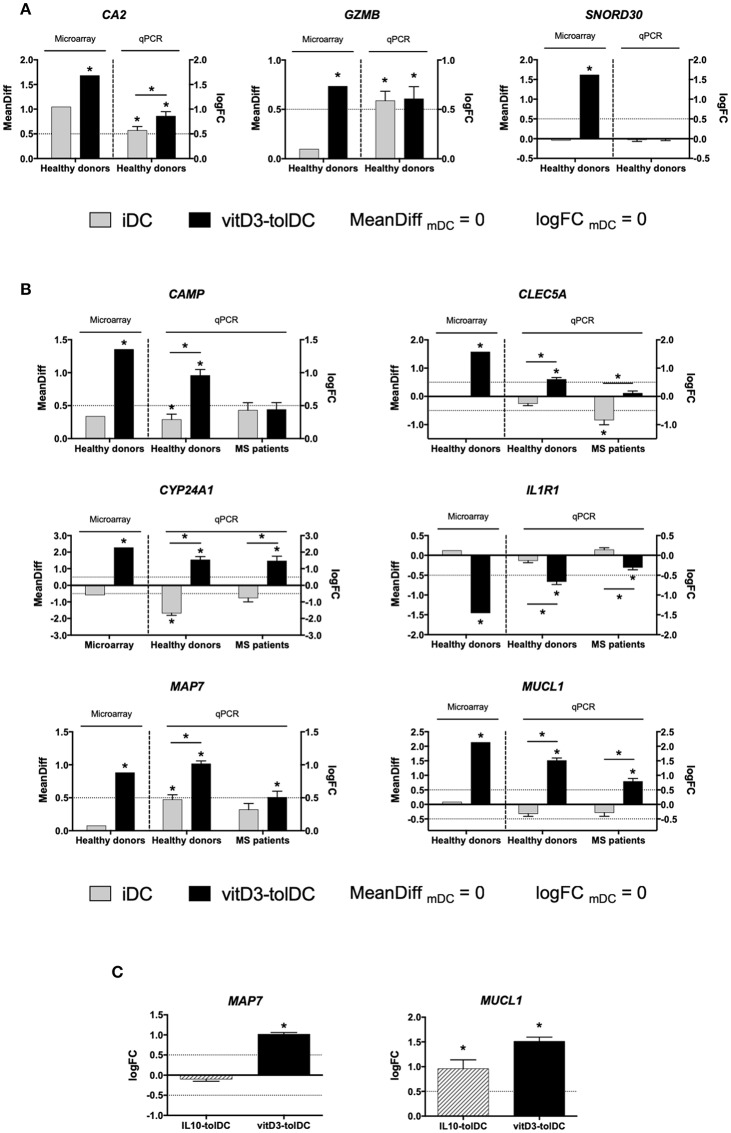
Expression of the selected genes as candidate biomarkers of vitD3-tolDC. (A) Expression of CA2, GZMB and SNORD30 in healthy donors by microarray (n = 5) and quantitative PCR (qPCR; n = 20, except CA2, in which n = 24) in immature dendritic cells (iDC), mature DC (mDC) and vitD3-tolDC. (B) Expression of CAMP, CLEC5A, CYP24A1, MAP7 and MUCL1 in healthy donors both by microarray (n = 5) and qPCR analysis (n = 24, except CYP24A1, in which n = 10) in iDC, mDC and vitD3-tolDC, and in multiple sclerosis (MS) patients by qPCR only (n = 10). (C) Expression of MAP7 and MUCL1 in vitD3-tolDC (n = 24) and in IL10-tolDC (n = 5) by qPCR. Data presented as the mean difference of expression (MeanDiff) or the decimal logarithm of fold change (logFC) expression for the microarray and qPCR results, respectively, in both cases normalized to mDC expression. Housekeeping genes GAPDH, TBP and CYPA were used as controls. One qPCR experiment was performed for each donor or patient, with triplicated measurements for each sample. Error bars corresponding to SEM. Dotted lines represent the logFC = 0.5 or −0.5 expression threshold. *p < 0.05. Friedman test with Dunn's correction, one-way ANOVA test with Geisser-Greenhouse correction or paired t-test.